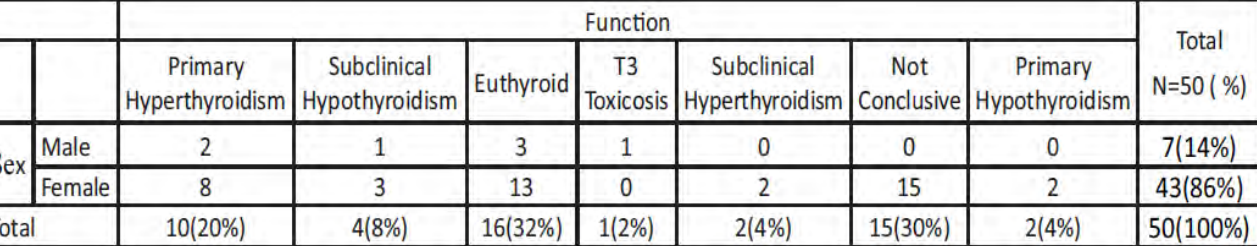
Table 1: cross tabulation of sex and TFT